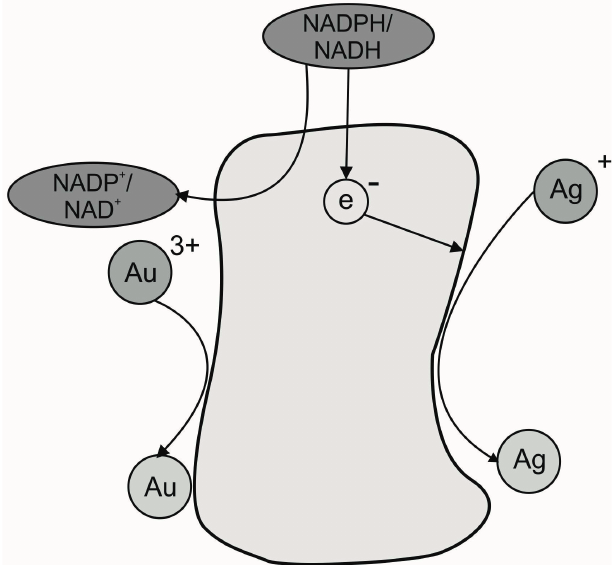
Figure 2. Hypothetical mechanism for silver and gold nanoparticles biosynthesis modified from [18] with permission from Elsevier, copyright